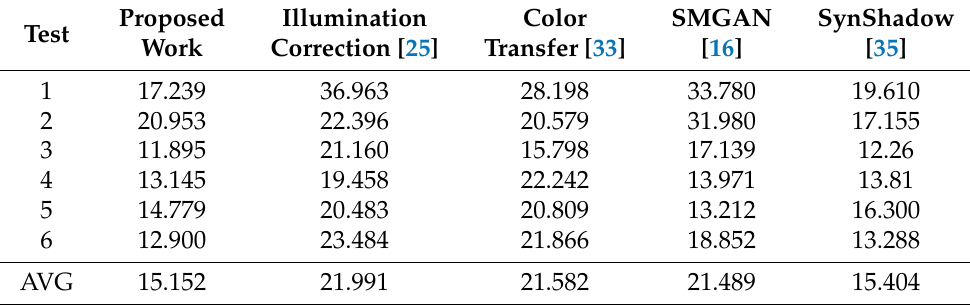
Table 1. Results comparison of SSDI